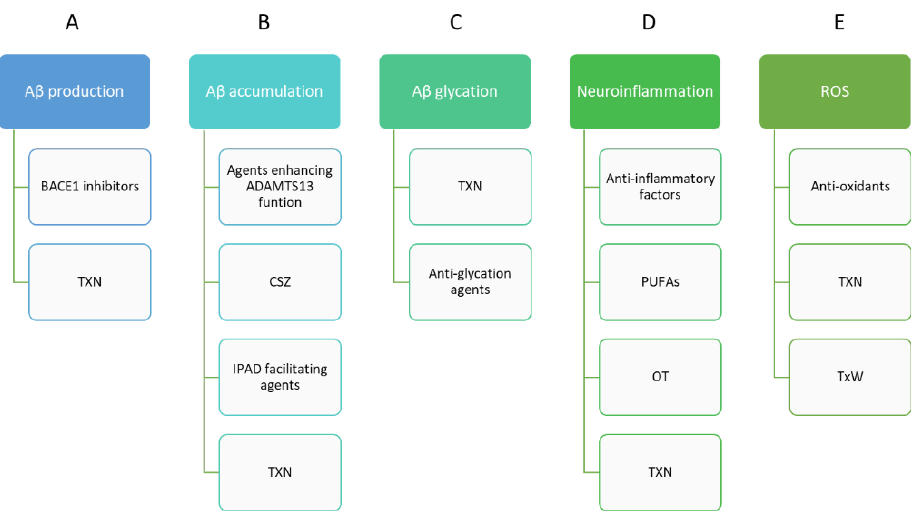
Figure 1. Pathological implications of amyloid- β and its role in potential therapeutic approaches for Alzheimer’s disease. In AD treatment, BACE1 inhibitors inhibit A β production ( A ). Another option is taxifolin (TXN) which, with its pleiotropic beneficial effects, suppresses the production and glycation of A β ; also, it is effective in reducing detrimental A β accumulation ( B ). Anti-glycation agents could reduce the accumulation of cytotoxic A β oligomers (A β glycation) ( C ). Agents that facilitate the formation of mature fibers would also be effective in facilitating the Intramural Peri-Arterial Drainage (IPAD) pathway or enhancing ADAMTS13 function. Anti-inflammatory mediators ( D ) and antioxidants ( E ) and may also exhibit protective effects against AD. A β , amyloid- β ; AD, Alzheimer’s disease; ADAMTS13, a disintegrin and metalloprotease with thrombospondin type I motif, member 13; BACE1, β -site amyloid precursor protein cleaving enzyme-1; CSZ, cilostazol; OT, oxytocin; PUFAs, polyunsaturated fatty acids; ROS, reactive oxygen species; TwX, Twendee X; TXN, taxifolin.